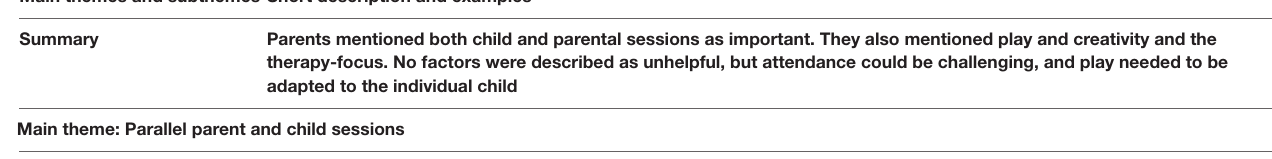
TABLE 6 | Factors parents described as helpful or